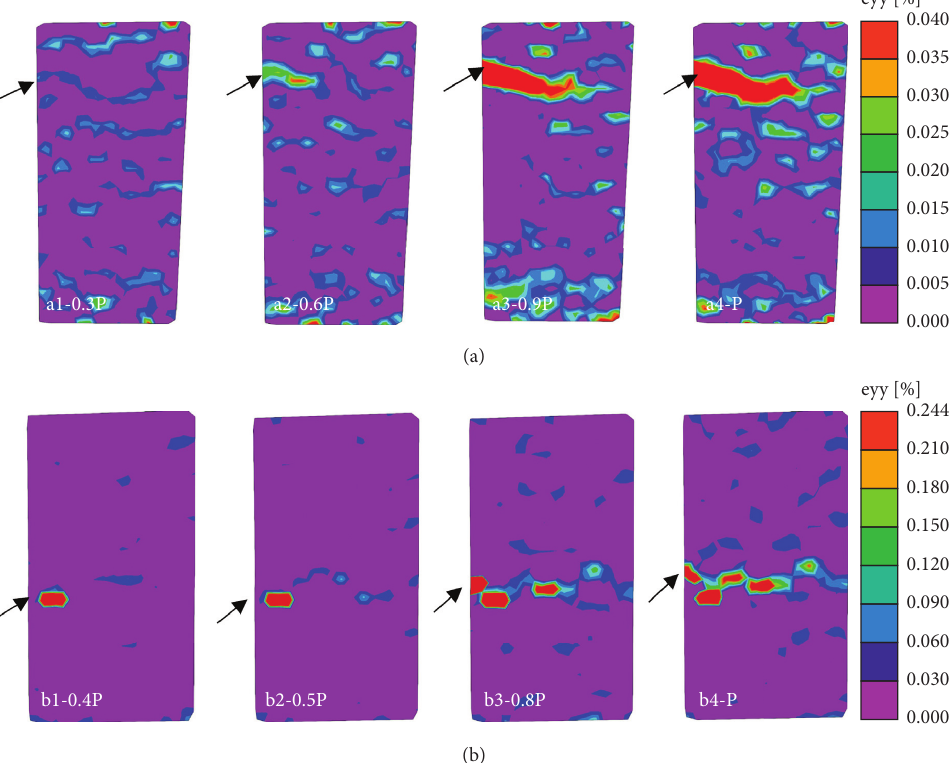
Figure 10: Vertical strain field for specimen with various interfacial angles at different loading stages. (a) C50-C50-BG-60 ° (side surface) and (b) C50-C50-BG-90 ° (primary